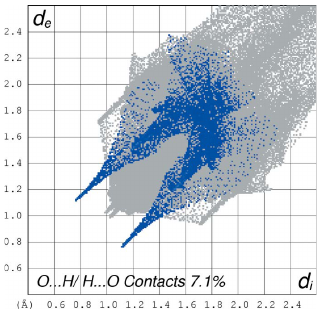
Figure 5 The two-dimensional fingerprint plot for the title compound depicting the contribution percentage of O (cid:2)(cid:2)(cid:2) H contacts.